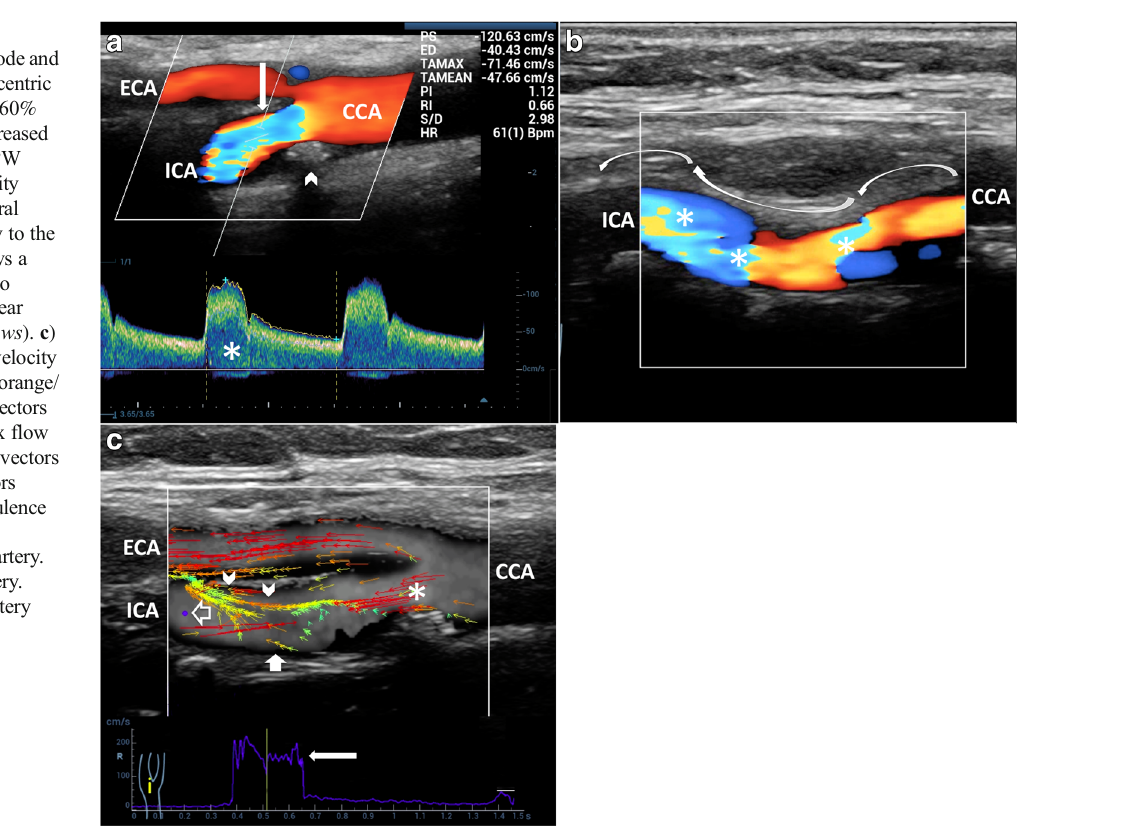
Fig. 12 Flow patterns in hemodynamically relevant stenosis. a ) B-mode and CD of the ICA sinus demonstrates a short plaque ( arrowheads ) causing severe stenosis: CD depicts a mixture of high velocities and directions (*), distally to the stenosis. b ) VFI shows high-velocity vectors